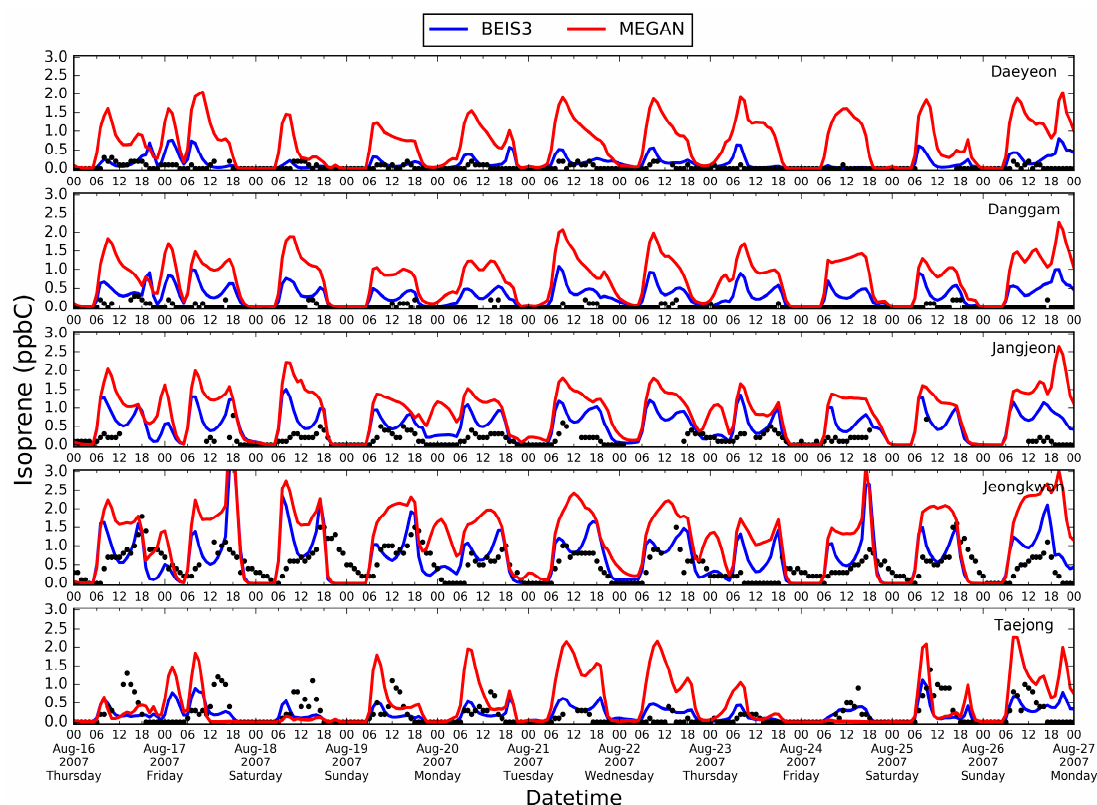
Figure 6. Hourly modeled (red lines for MEGAN and blue lines for BEIS3) and observed (black dots) isoprene concentrations at five PAMS sites.